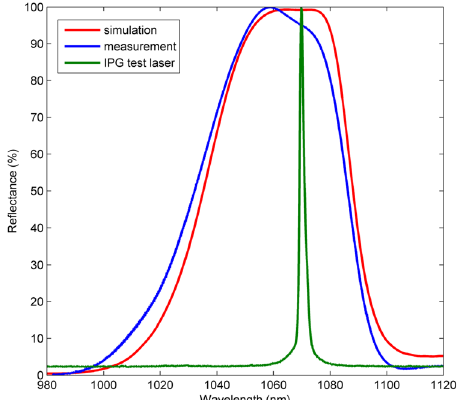
Fig. 7 Re fl ection spectrum of the diamond mirror used for LIDT measurements at 1070 nm. A diamond mirror measured (blue curve) and simulated (red curve) re fl ection spectrum at normal incidence. Green curve shows the spectrum of the 10 kW IPG laser used during damage testing plotted in